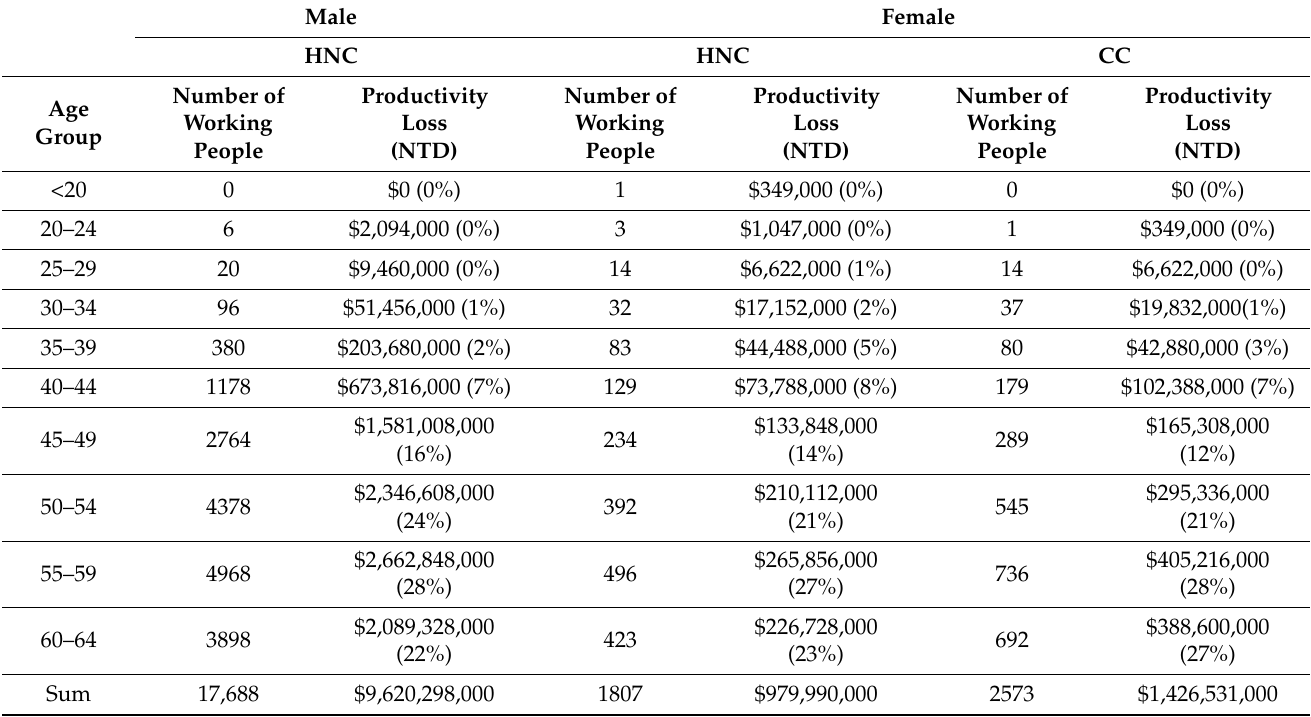
Table 3. Estimated productivity loss in Taiwan due to CC and HNC mortality in 2019.